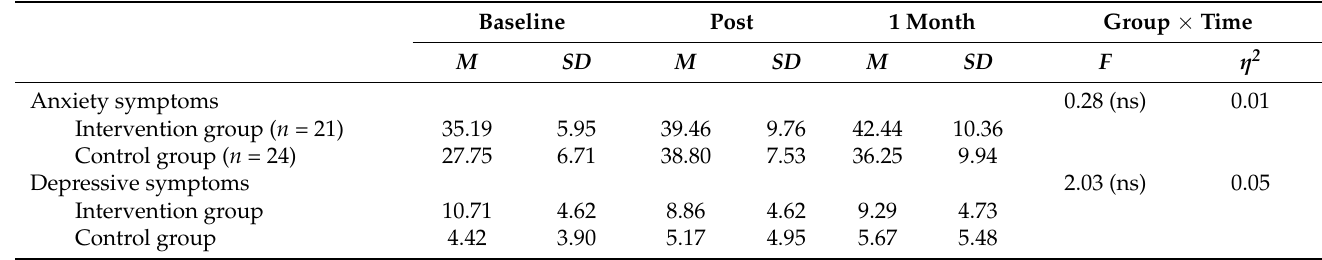
Table 5. Descriptive and inferential statistics for anxiety and depressive